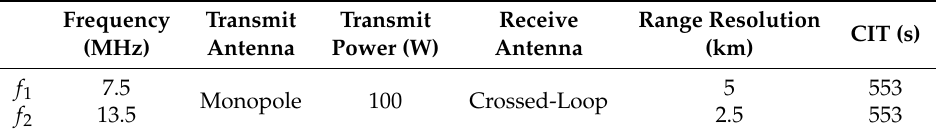
Table 1. OSMAR-SD radar system configuration.